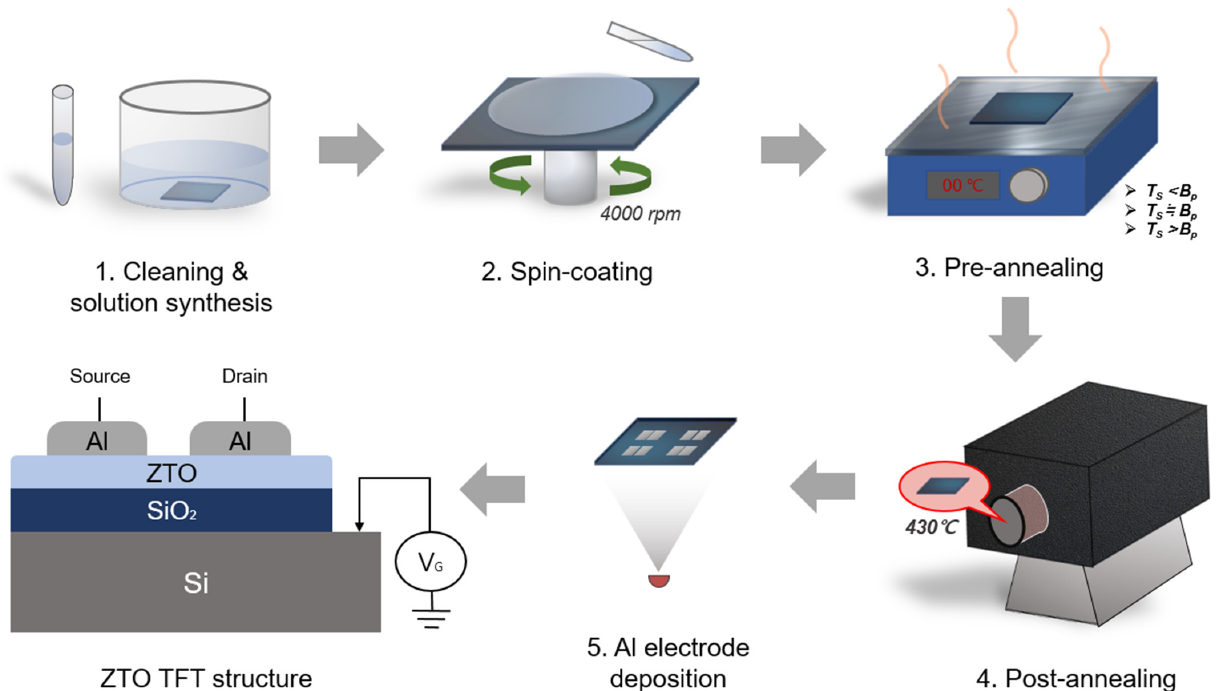
Figure 1. Schematic of the process of the solution-processed ZTO TFTs. AFM (NX20, Park Systems, Suwon-si, Korea) was used to measure the surface mor-